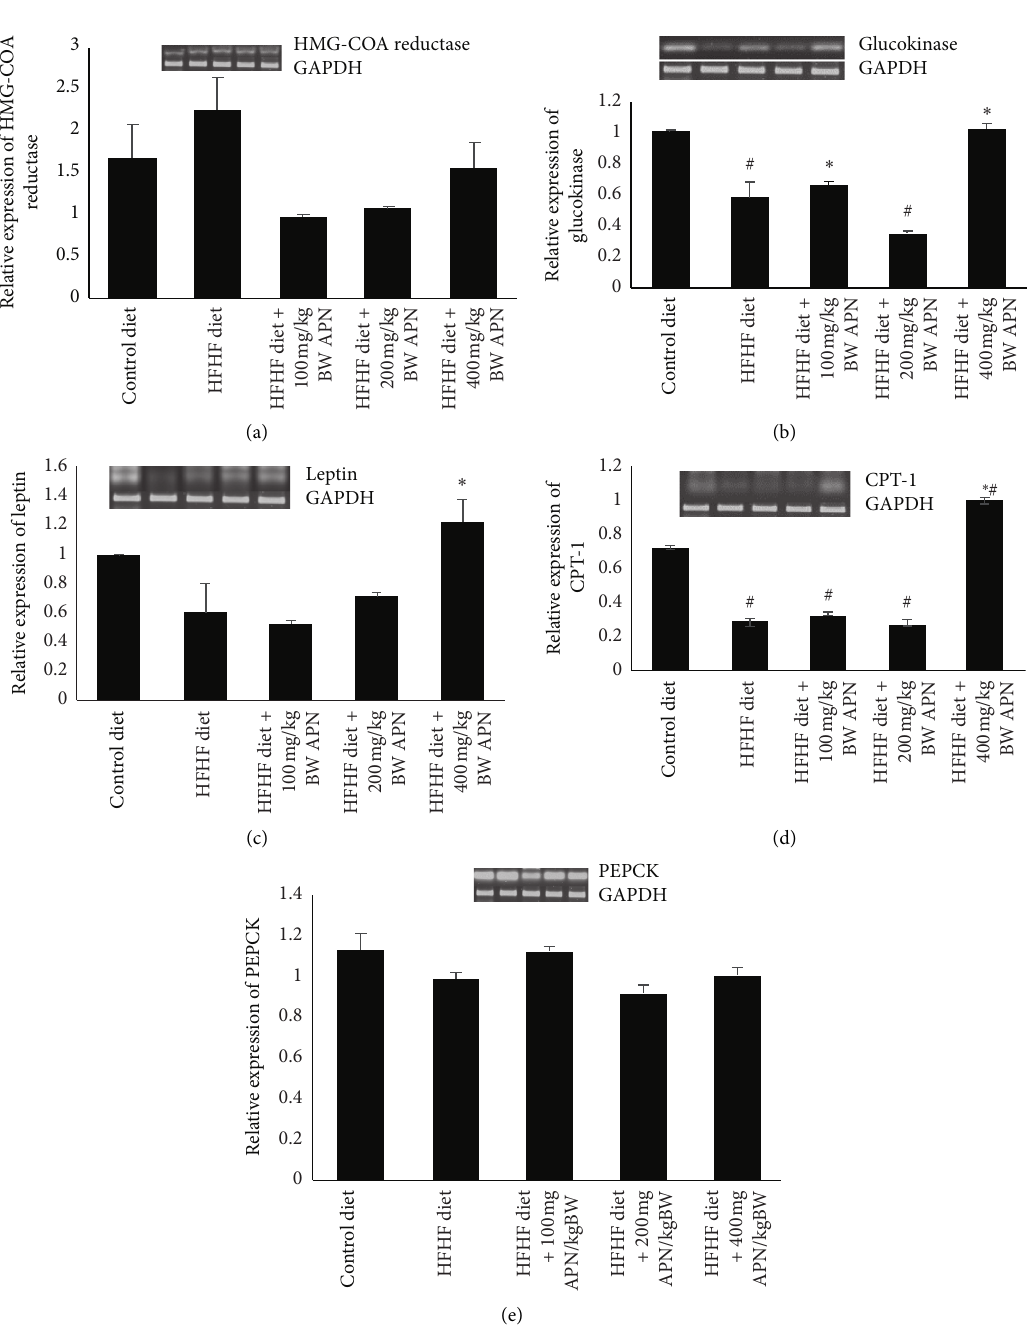
Figure 5: Effect of APN on the relative expression of some metabolic genes. (a) Relative expression of HMG-COA reductase; (b) relative expression of glucokinase; (c) relative expression of leptin; (d) relative expression of CPT-1; (e) relative expression of PEPCK. β -Actin and GAPDH were used as the reference gene to calculate the relative expression of the genes. Bars with # are significantly ( P < 0 . 05) different from control while bars with ∗ are significantly different ( P < 0 . 05) from HFHF-fed